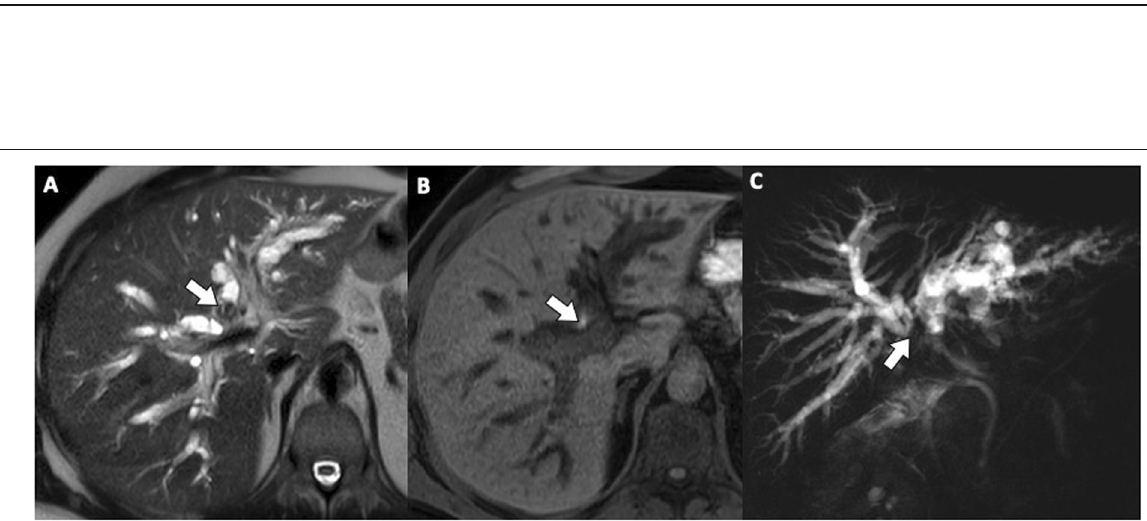
Fig. 3 A 48-year-old man with hydatid liver cyst complicated with communicating rupture. a , b US images show a focal anechoic liver lesion with internal septa and hyperechoic peripheral rim, with some posterior shadows, diffuse biliary dilatation and endoluminal hyperechoic foci (arrowhead) into the common bile duct with no posterior acoustic shadows. Axial CT scan in the portal venous phase ( c ) and MR image on T2- weighted sequence ( d ) confirm the presence of a liver cyst and diffuse biliary dilatation, with material into the biliary tree (arrow). These features are consistent with progressive migration of the hydatid sand and membranes from the hilar confluence to the common bile duct